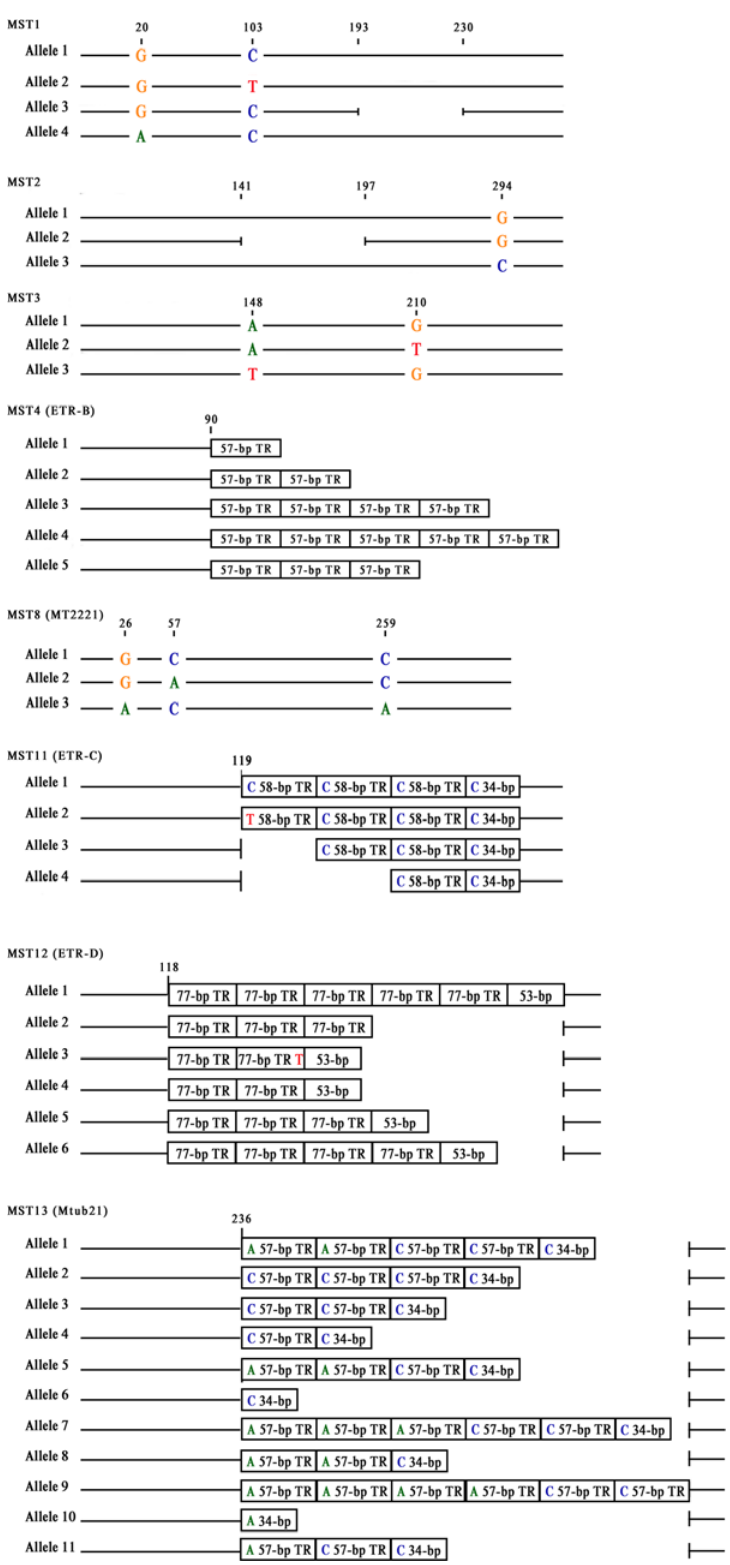
Figure 2. Alleles identified in 8 intergenic spacers in M.tuberculosis . Eight intergenic spacers MST1, MST2, MST3, MST4, MST8, MST11, MST12 and MST13 were sequenced in M. tuberculosis isolates. Sequences were aligned to highlight differences between isolates, including mutations (colored letters featuring nucleotide bases) and variable number and variable size in tandem repeats (featured by blocks). Numbers in exponent refers to the base position in M. tuberculosis H37Rv reference sequence (GenBank: AL123456).